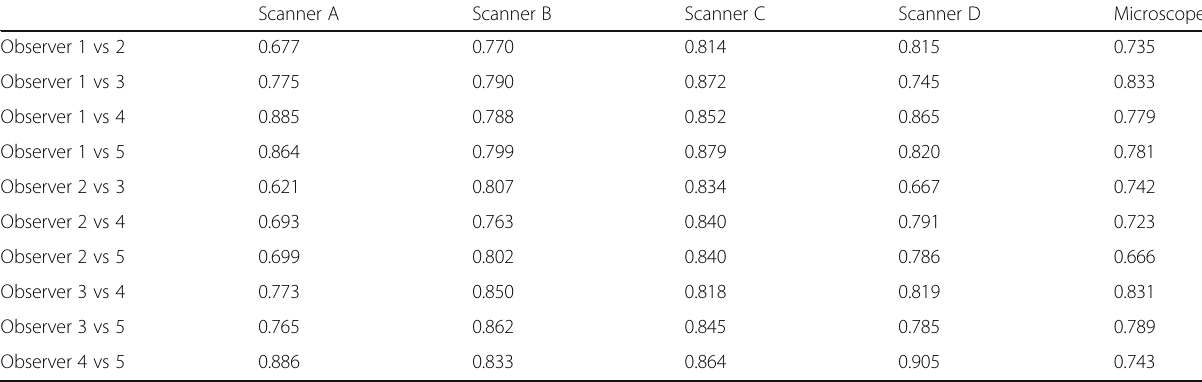
Table 2 Inter-observer agreement in each observation method (Kappa coefficient) Scanner A Scanner B Scanner C Scanner D